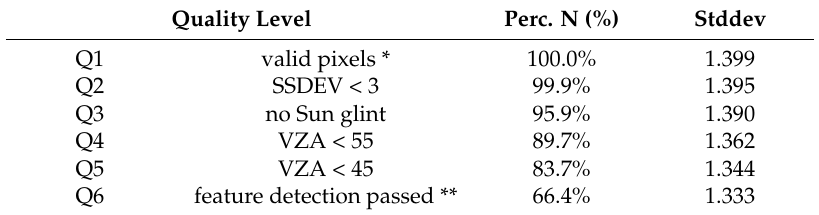
Table 3. The six quality levels indicate which additional tests are passed. The levels are cumulative (e.g., Q4 means Q3 AND VZA < 55). The average data availability (compared to Q1) and the average standard deviation during the validation are shown for the different quality levels. Quality Level Perc. N (%) Stddev Q1 valid pixels * 100.0% 1.399 Q2 SSDEV < 3 99.9% 1.395 Q3 no Sun glint 95.9% 1.390 Q4 VZA < 55 89.7% 1.362 Q5 VZA < 45 83.7% 1.344 Q6 feature detection passed ** 66.4%